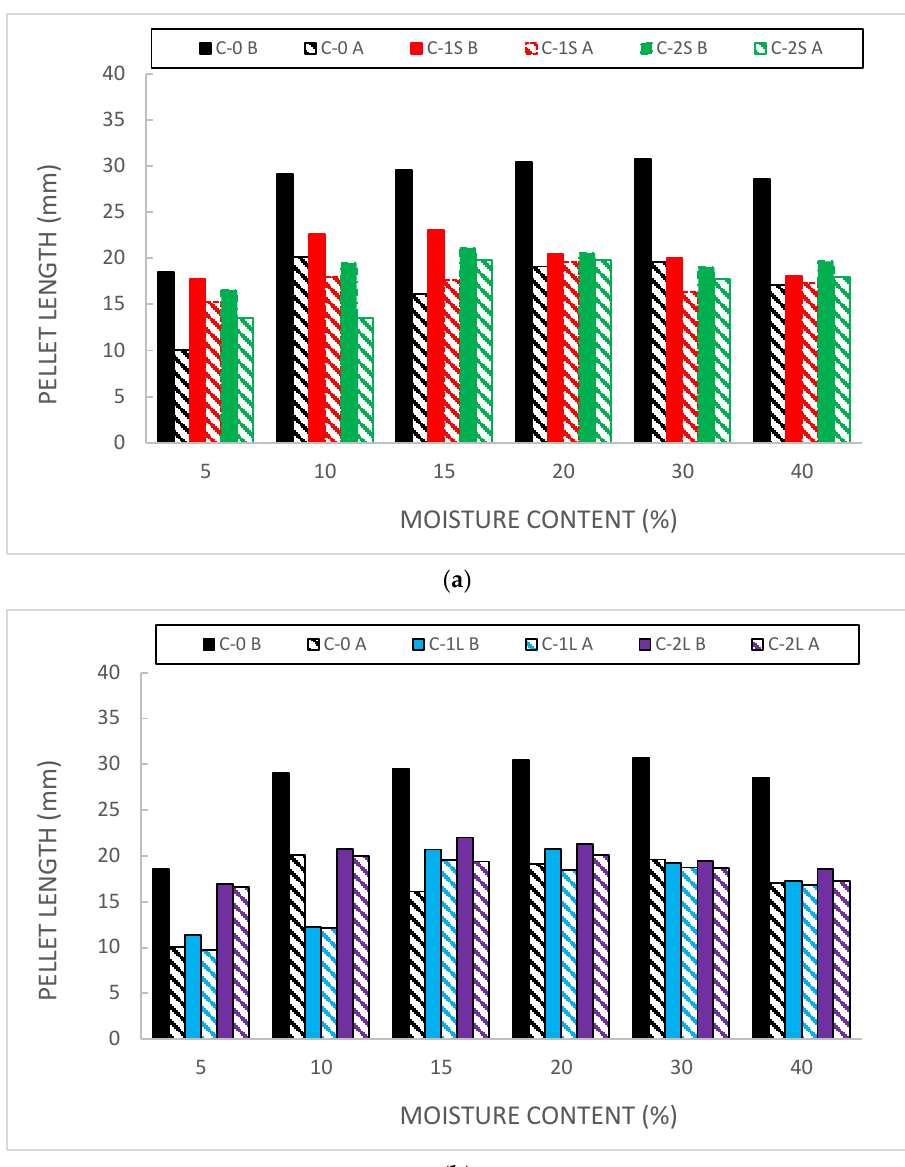
Figure 5. Pellet length before (B) and after (A) the abrasion and knocking test. ( a ) Sugar and ( b ) lignosulphonate containing mixes.